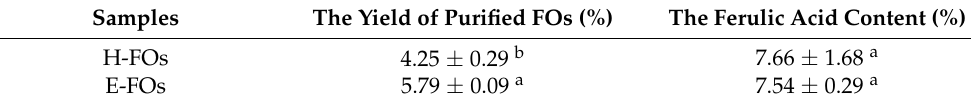
Table 2. The yield of purified FOs (%) and the ferulic acid content of purified FOs (%, dry basis).